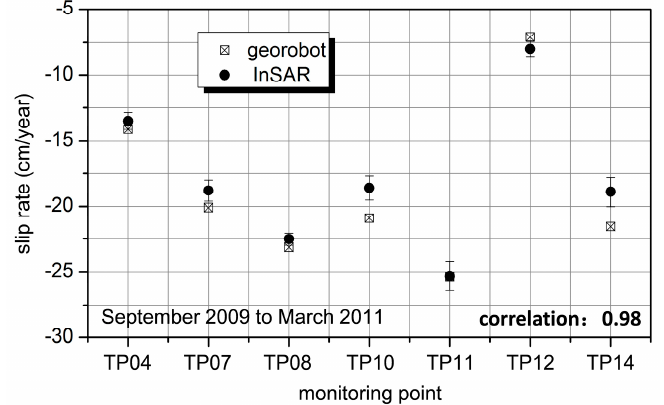
Figure 9. Comparison between InSAR and georobot results from September 2009 to March 2011. X-axis represents the monitoring points, and the location of these points are shown in figure 6.